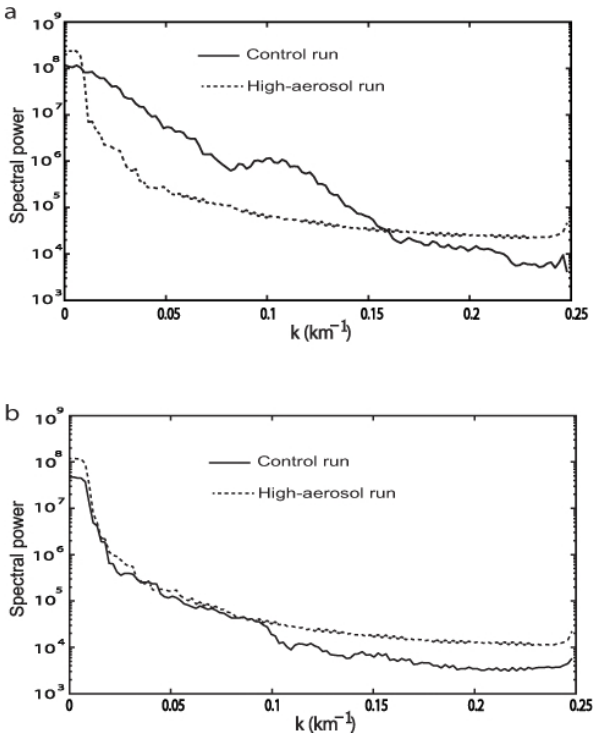
Fig. 9. Frequency distribution of WP (a) at the time of maxi- mum difference in homogeneity around 03:00LST on 24 January and (b) at the time of minimum difference in homogeneity around 12:00LST on 24